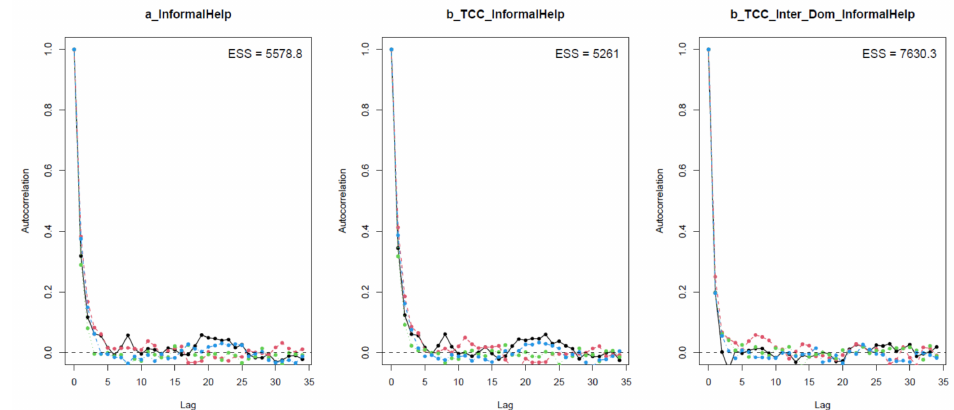
Figure A4. Autocorrelation plots for Model 2 (cid:48) s posterior coefficients.